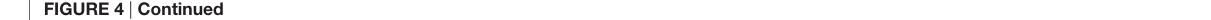
FigUre 4 | continued cDr3 length of isotypes and subclasses . Deduced amino acid sequence of CDR3 region of IgM, IgD, IgG3, IgG1, IgA1, IgG2, IgG4, IgE, and IgA2 were collected from 12 individuals. The CDR3 length was calculated based on amino acid sequence from conserved Cys104 to Trp118 or Phe118. Percentage frequencies of each CDR3 length were plotted by a bar plot (a) . Closed bar indicates percentage frequencies in CDR3 length of IgM (control), while open bar indicates respective immunoglobulin subclasses. To compare difference in the CDR3 length between immature and mature B cells, difference in the percentage frequencies between IgM and either IgD, IgG, IgA, and IgE or IgM were plotted at each position (B) . Negative values in the left half and positive values in right half indicate a shortening of CDR3 length in respective Igs compared with